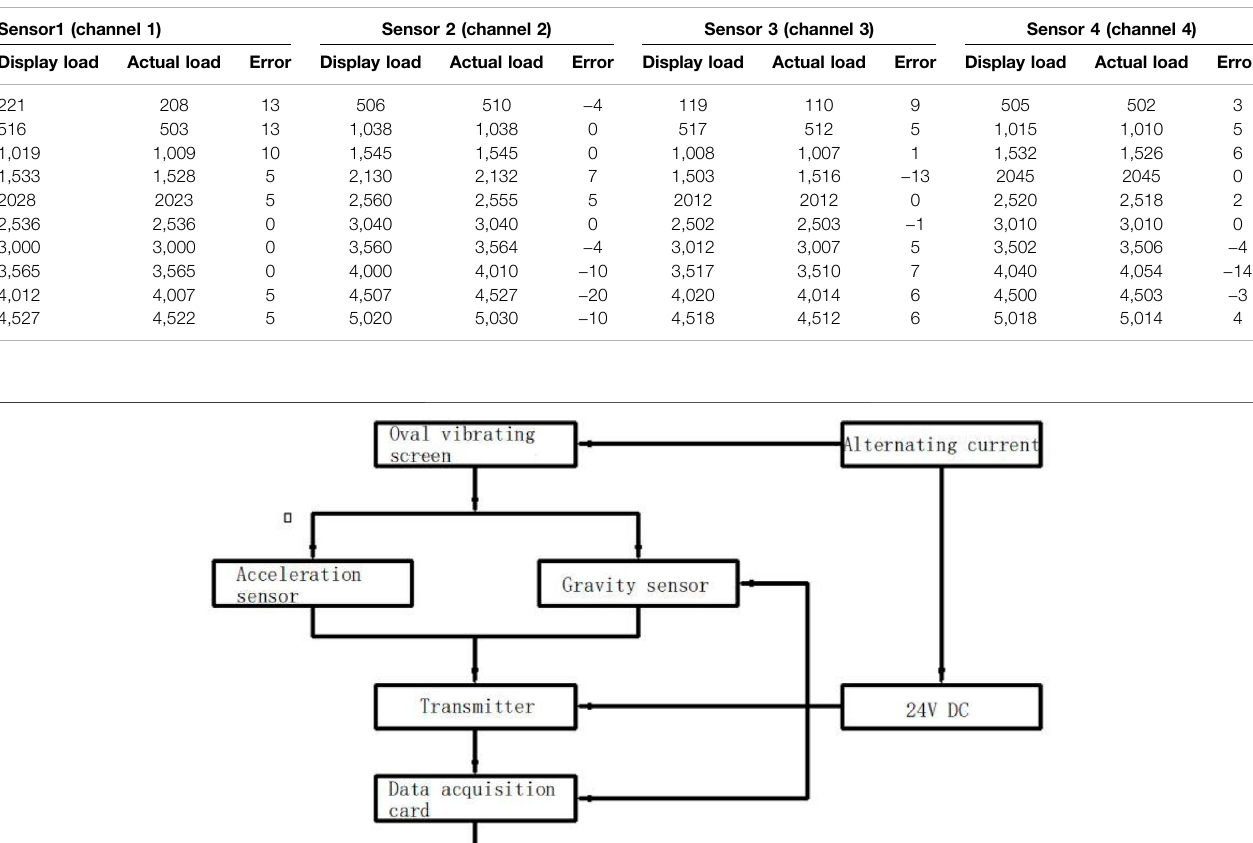
TABLE 2 | Veri fi cation of measurement results.